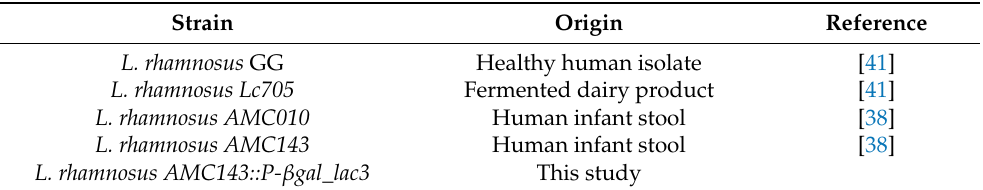
Table 1. Bacterial strains used in this